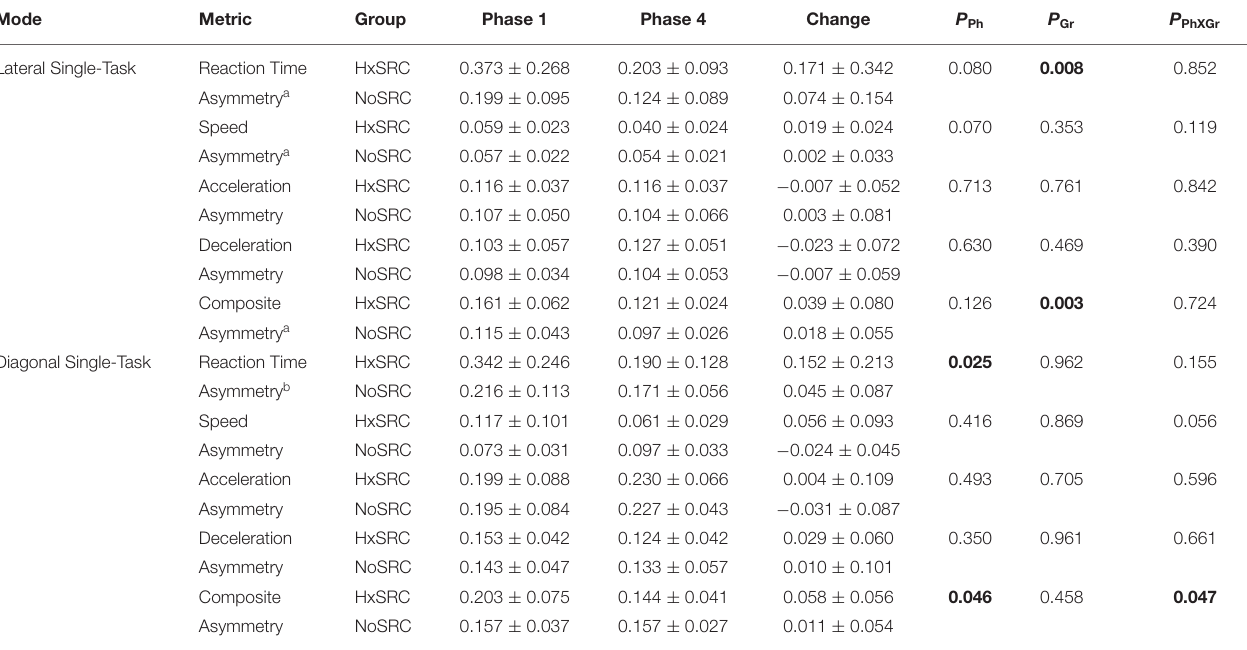
TABLE 7 | Group mean ± standard deviation for Single-Task